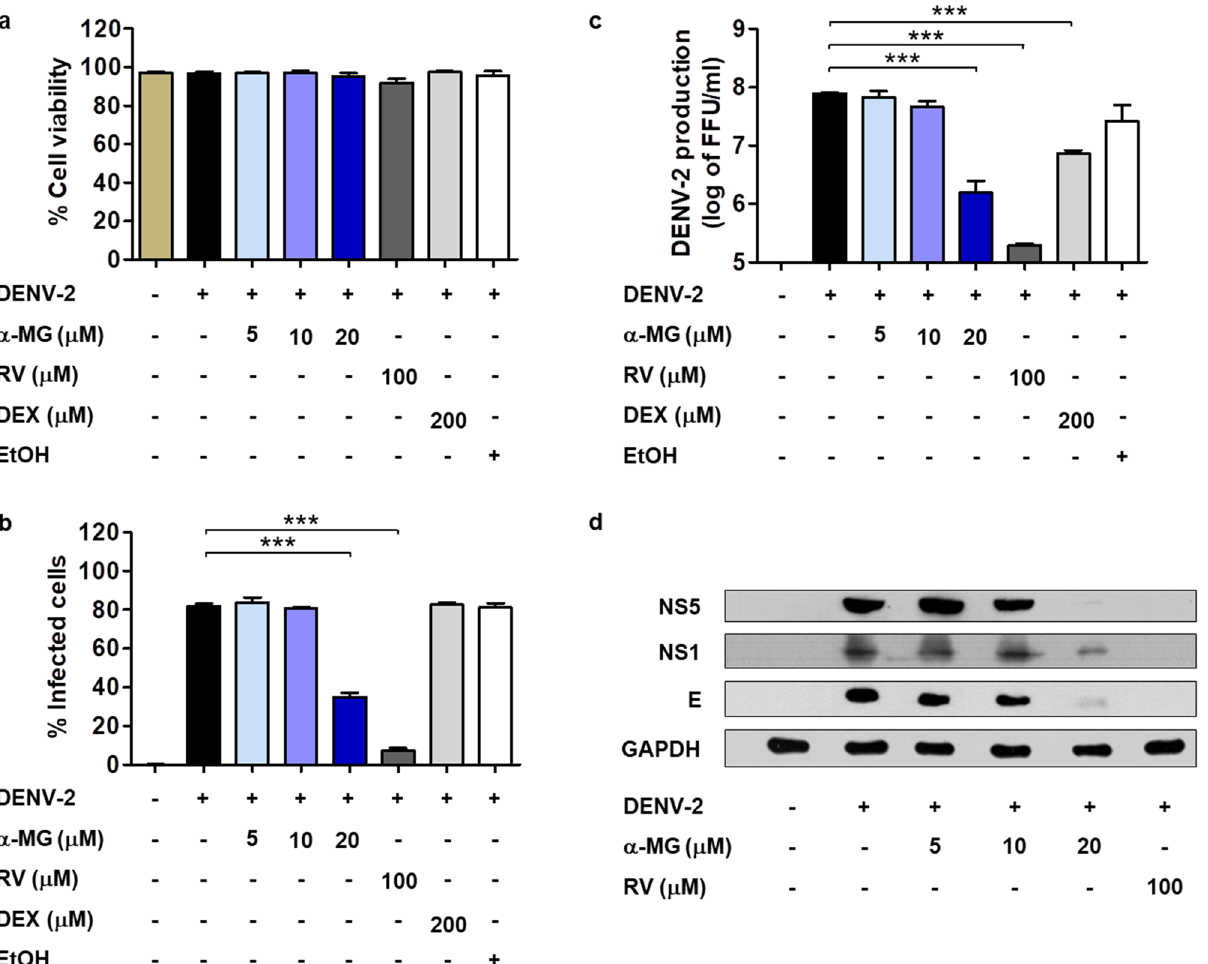
Figure 1. α-MG reduces DENV-2 infection, DENV-2 production, and downregulation of DENV-2 protein expression. HepG2 cells were infected with DENV-2 at a MOI of 5 and treated with α-MG, ribavirin (RV), dexamethasone (DEX), or ethanol (EtOH) solvent at the indicated concentrations for 24 h. ( a ) The percentages of cell viability were evaluated by trypan blue exclusion assay. ( b ) The percentages of infected cells were determined by flow cytometry using the mouse monoclonal anti-DENV-E antibody (4G2). ( c ) DENV-2 production in culture supernatants was determined by FFU assay. The results were collected from three independent experiments, and the mean ± SD values were calculated and plotted. Statistical differences compared to the control group were calculated by one-way ANOVA and Tukey’s HSD test (* p < 0.05, ** p < 0.01, *** p < 0.001). ( d ) The expression levels of NS5, NS1, and E protein after treatment with α-MG as examined by immunoblot analysis using the anti-NS5, anti-NS1, and anti-E antibodies,